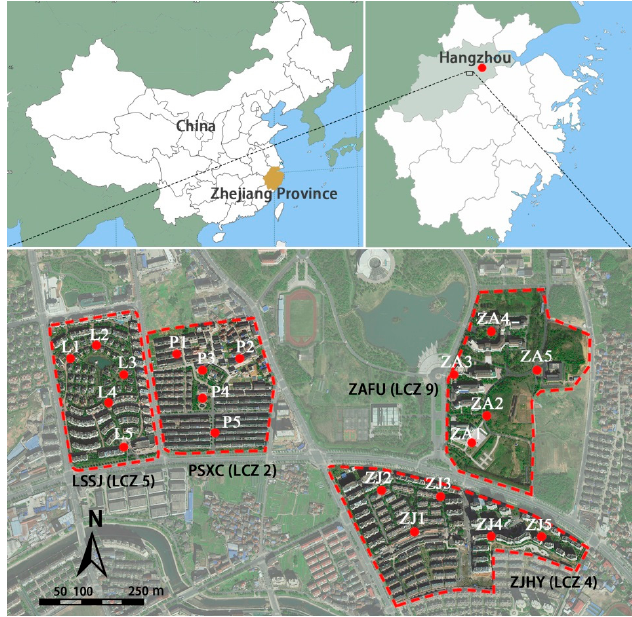
Figure 1. Location of the study area and measurement points.